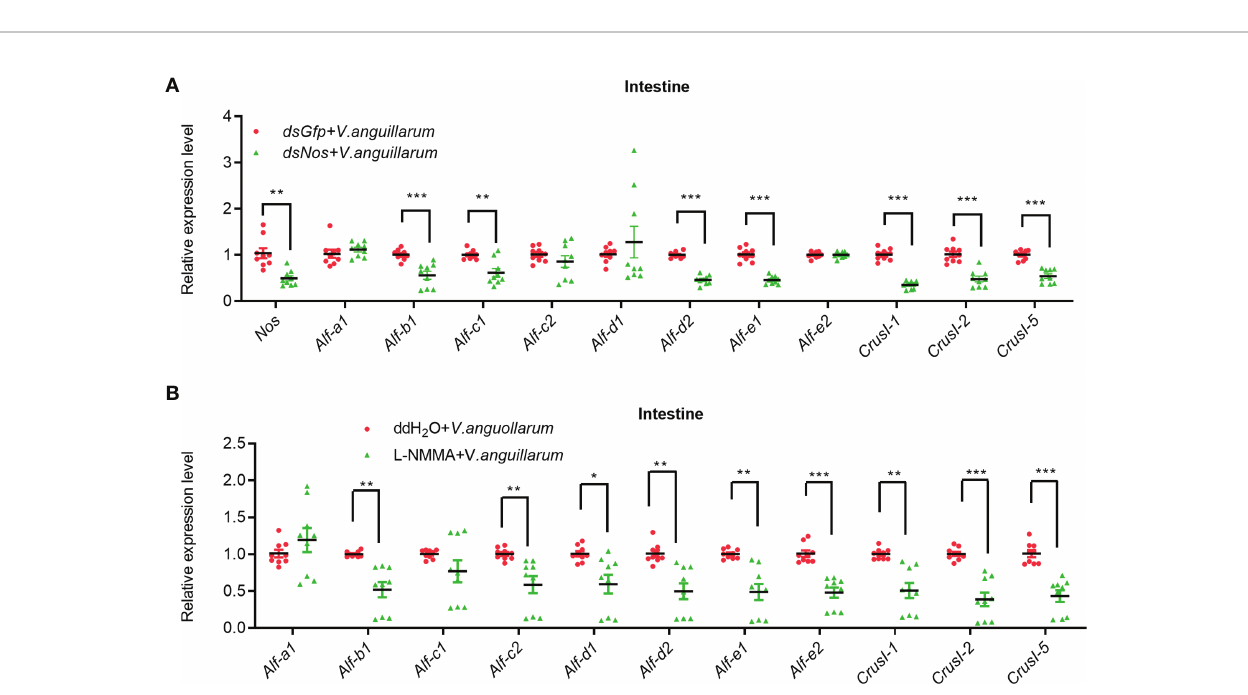
FIGURE 6 | The expression of AMPs was inhibited in intestines of shrimp after knockdown of Nos or L-NMMA treatment with bacterial challenge. (A) After knockdown of Nos , the mRNA expression levels of AMPs were measured by qPCR in intestines of shrimp with bacterial challenge; dsGfp injection was used as the control. (B) The mRNA expression levels of AMPs in intestines of L-NMMA-treated shrimp with bacterial challenge detected by qPCR; ddH 2 O treatment was used as the control (* p < 0.05, ** p < 0.01, *** p <